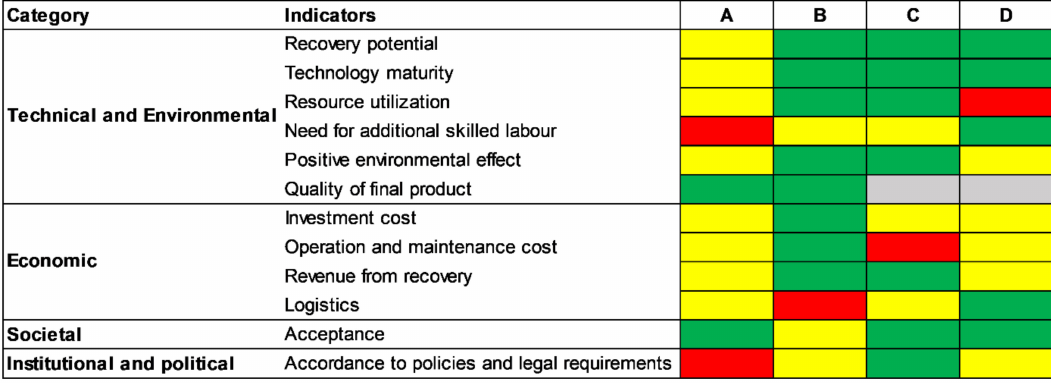
Figure 5. Comparison of resource recovery scenarios. ( A ) Struvite recovery; ( B ) co-composting of sewage sludge; ( C ) biogas recovery from co-digestion; ( D ) energy recovery from co-processing